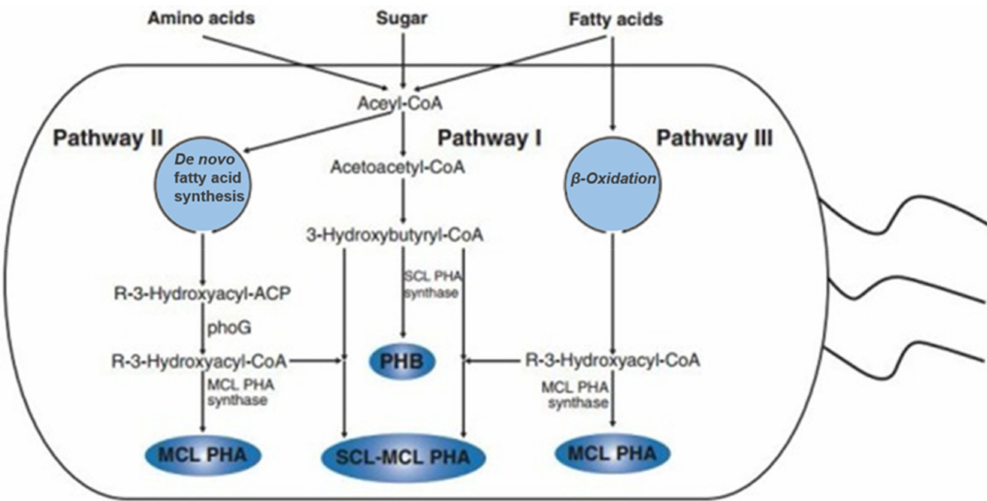
Figure 2. Biosynthesis of PHAs in bacteria. Reproduced with permission from [25]. Copyright 2015 Elsevier Ltd.